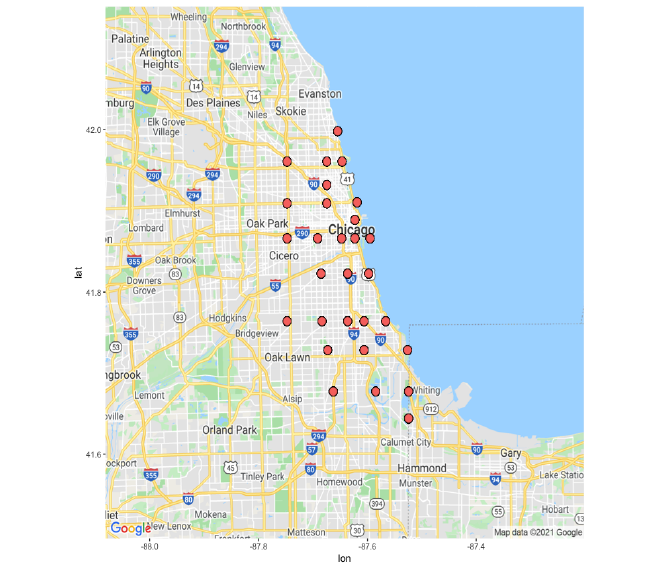
Figure 1. The sensor locations in the dense dataset.